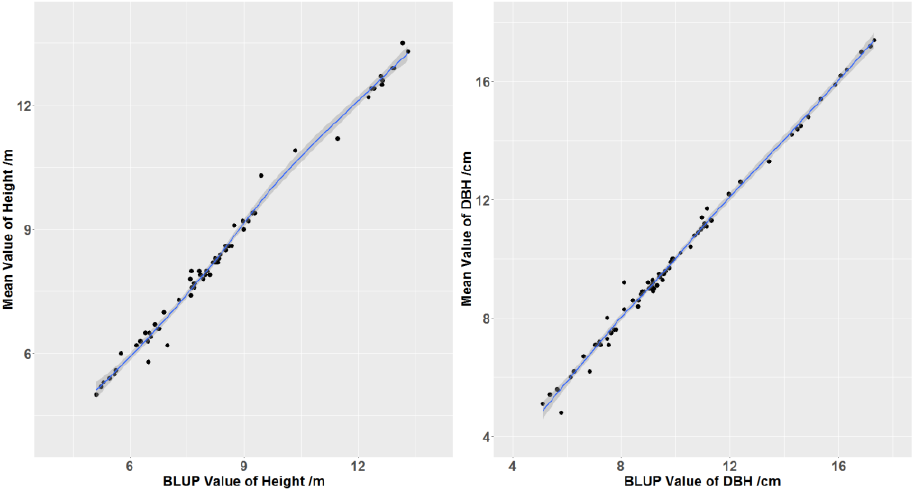
Figure 3. The relationship between BLUP value and mean value.